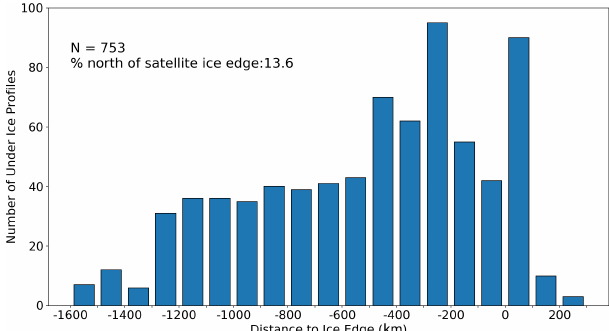
Figure 1. Distribution of great circle distances of under-ice pro- files to the estimated satellite sea ice edge (latitude of 15% sea ice concentration contour). Negative values indicate that the profile is poleward of the ice